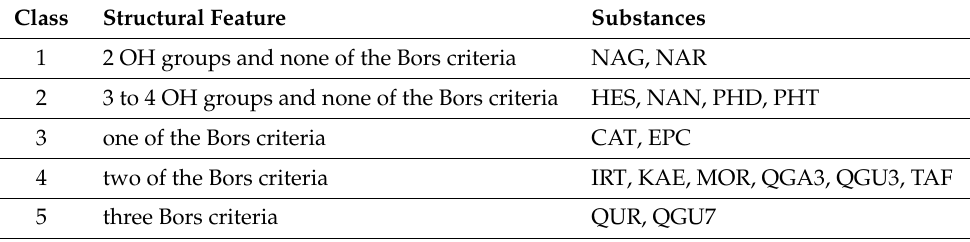
Table 2. Reclassification of flavonoids based on their structural